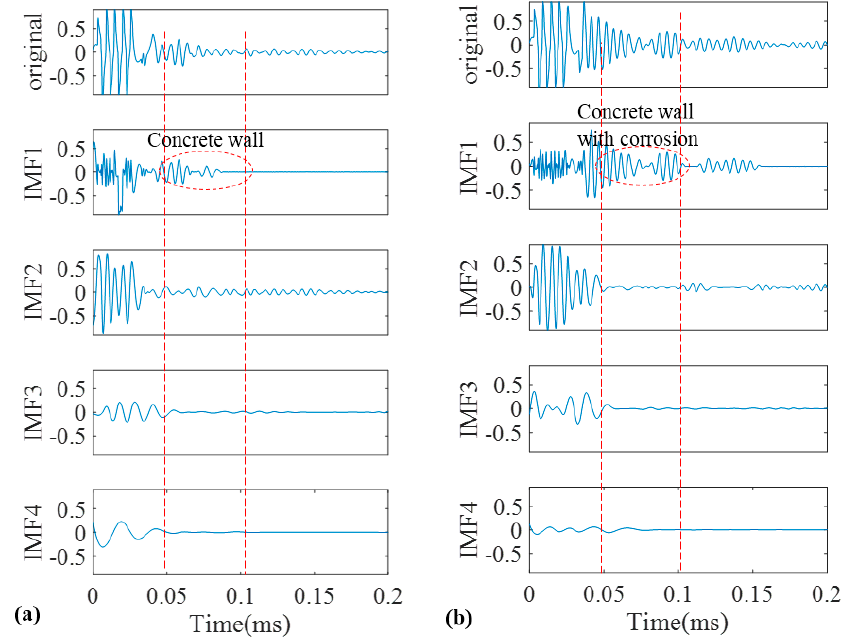
Figure 17. Decomposition of field test signals into their IMFs by EMD for the pristine pipe ( a ); and the pipe with a natural corrosion ( b ).